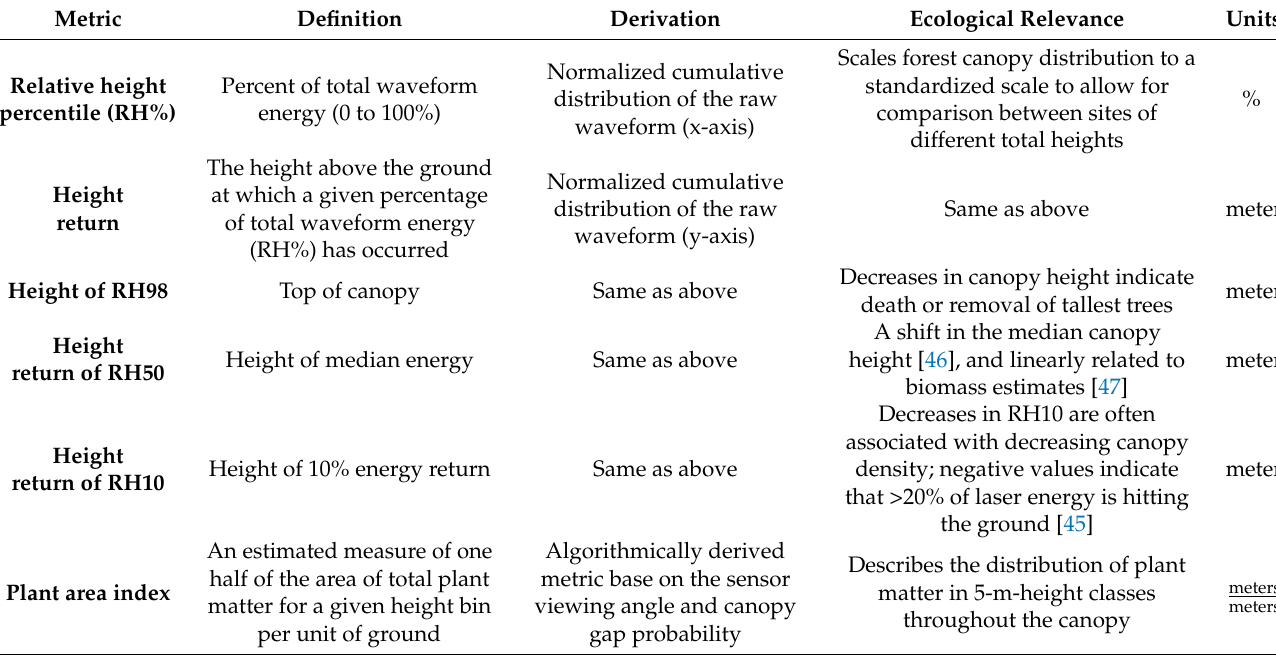
Table 2. Description of metrics of interest and their ecological